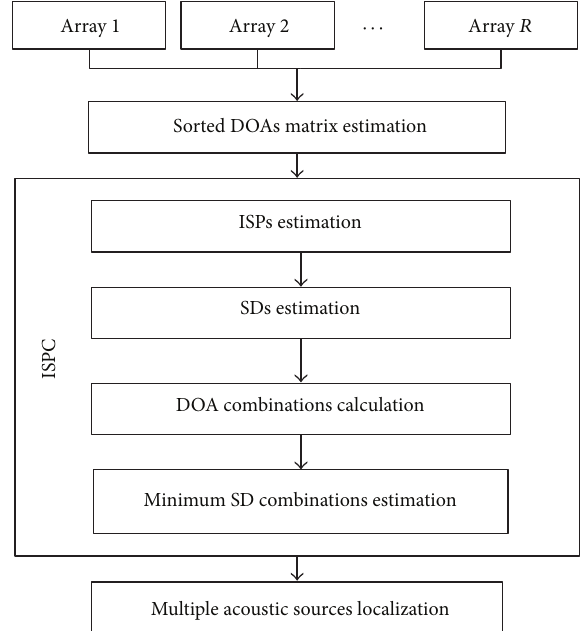
Figure 2: The steps for the ISPC